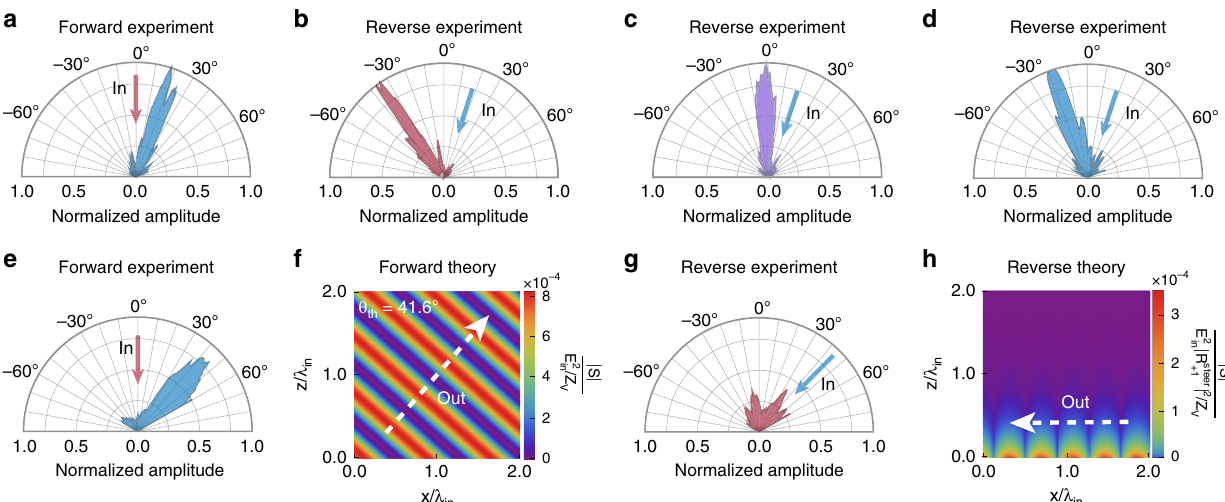
Fig. 3 Nonreciprocity in beam steering. a A normally-incident ( k in = 0) beam is up-converted to ω in + Ω and steered to an angle ≈ + 18° with a phase gradient β x = 44 m − 1 . Three dominant reverse pathways are allowed ( b – d ). b Momentum nonreciprocity: Re fl ection from + 18° of the up-converted beam undergoes a down-conversion to ω in and is steered to ≈ − 36°. c Frequency nonreciprocity: Re fl ection from + 18° undergoes an up-conversion to ω in + 2 Ω and is normally re fl ected. d Frequency and momentum nonreciprocity: Beam from + 18° is specularly re fl ected at ω in + Ω , differing both in frequency and direction of propagation from the original input beam. e Forward measured re fl ection beyond threshold: the input beam is steered to ≈ + 43° for β x = 96 m − 1 , which is larger than the + 30° threshold. f Computed re fl ected Poynting vector distribution for the forward process in e . g Measured reverse scattering to ω in resulting in photon-to-surface wave conversion and complete optical isolation. h Calculated pro fi le of evanescent surface waves corresponding to the reverse process in g . In all panels ω in = 2 π × 6.9 GHz and Ω = 2 π × 50